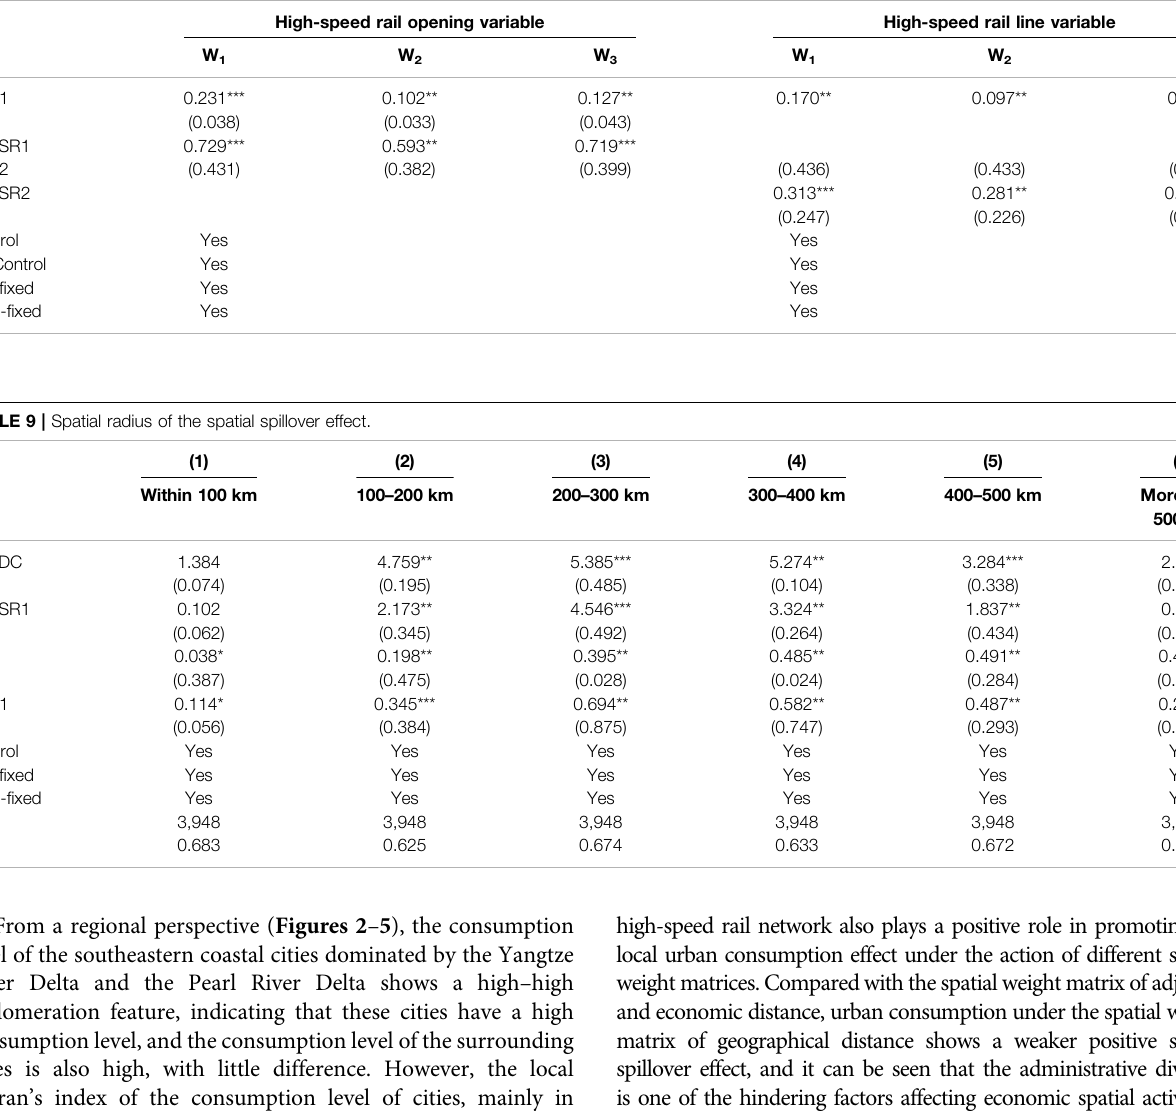
TABLE 8 | Robustness test.